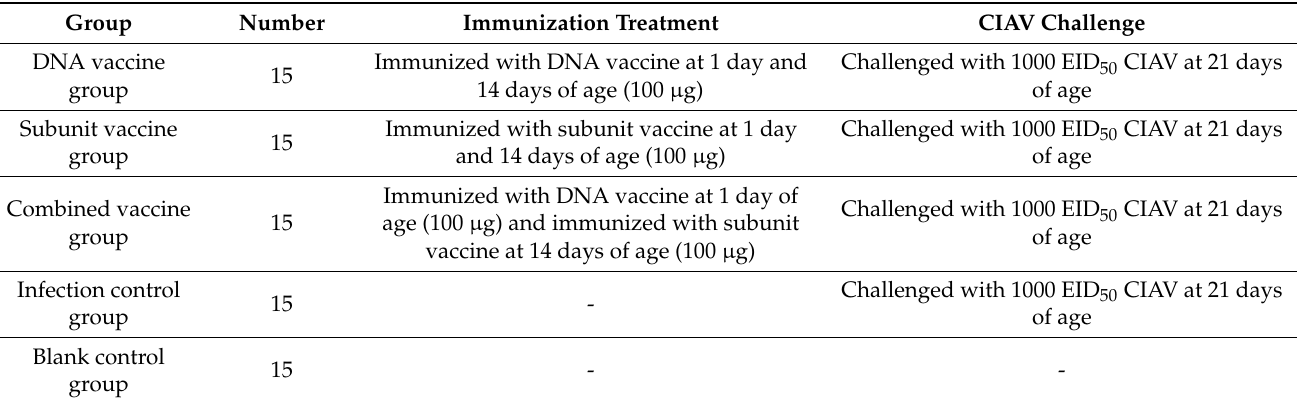
Table 3. Groups of vaccine protective